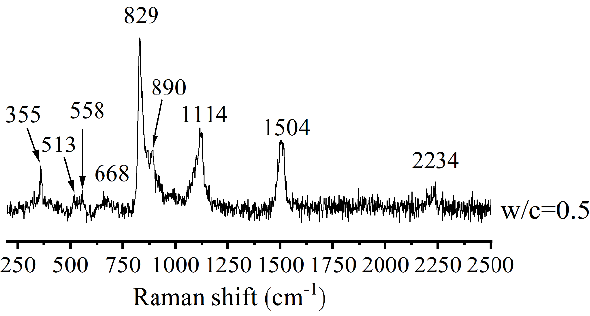
Figure 5. Raman spectra of hydration products (the control).